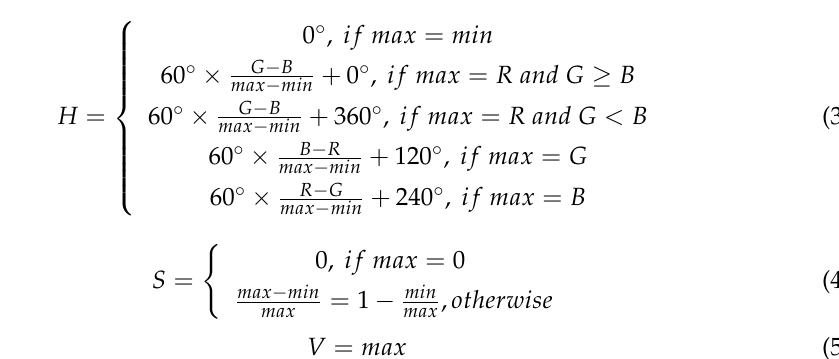
Figure 17. The imaging diagram of the laser spot on the mineral powder plane. ( a ) Cloudy day. ( b ) Sunny day.